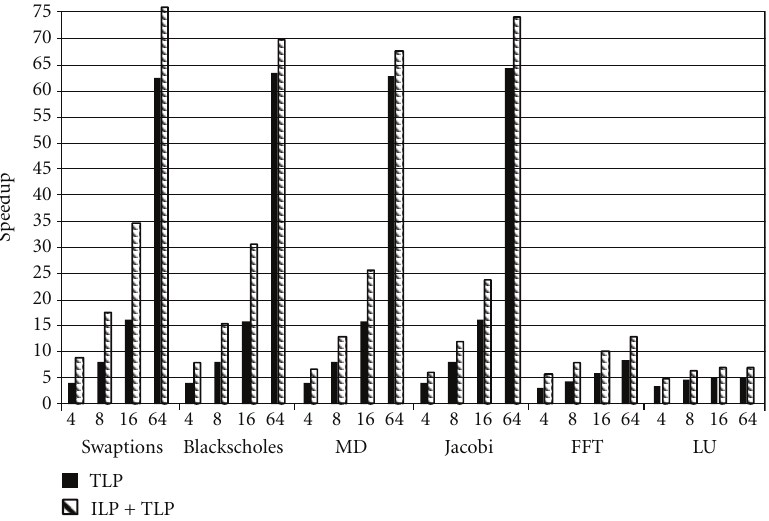
Figure 4: Performance of TLP and ILP + TLP exploration using RC#1 setup.